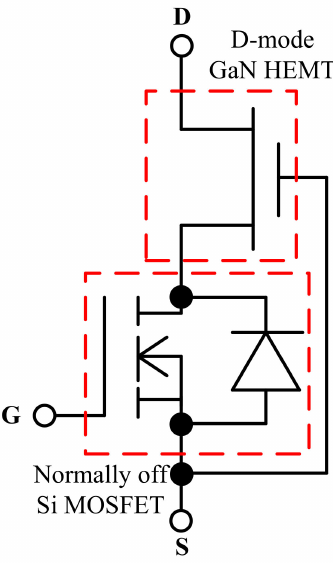
Figure 4. Cascode GaN HEMT. Table 1. General comparison of normally off GaN high electron mobility transistors (HEMTs).